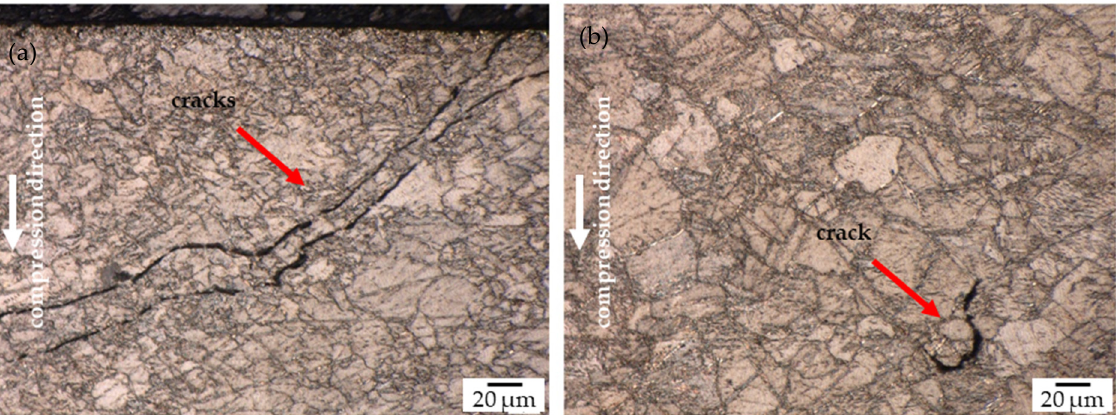
Figure 12. Light optical micrograph (1000×) of the formed (250 °C, 1 s − 1 ) AZ31 magnesium alloy (point I), ( a ) crack formation in the upper sample edge, ( b ) crack formation along the grain boundary (1/6 position).